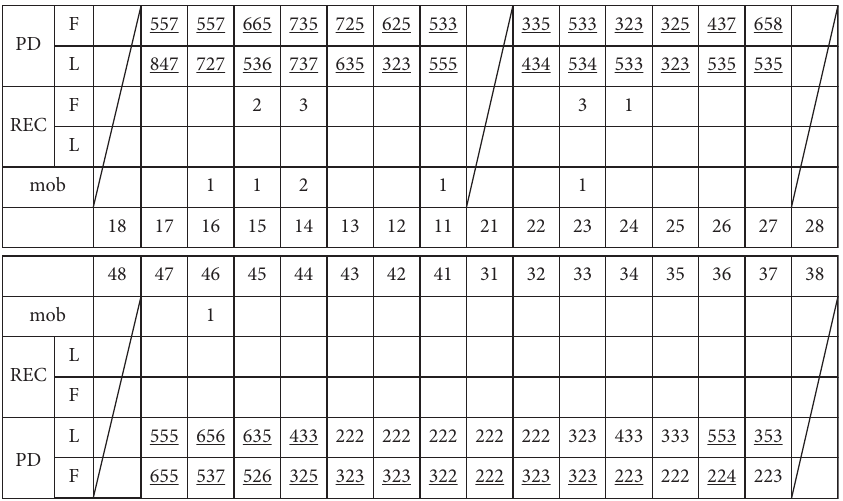
Figure 1: Example for periodontal examination record of one patient at first visit (mm). Table 2: Association of the number and proportion of teeth with ≥ 5mm PD and CRP concentration.